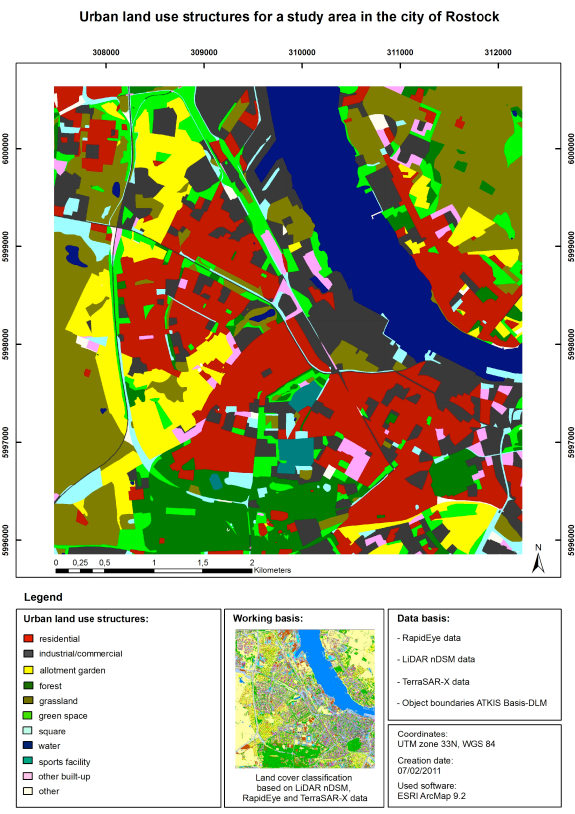
Fig. 2: Utilized features for class assignment of the various roof types